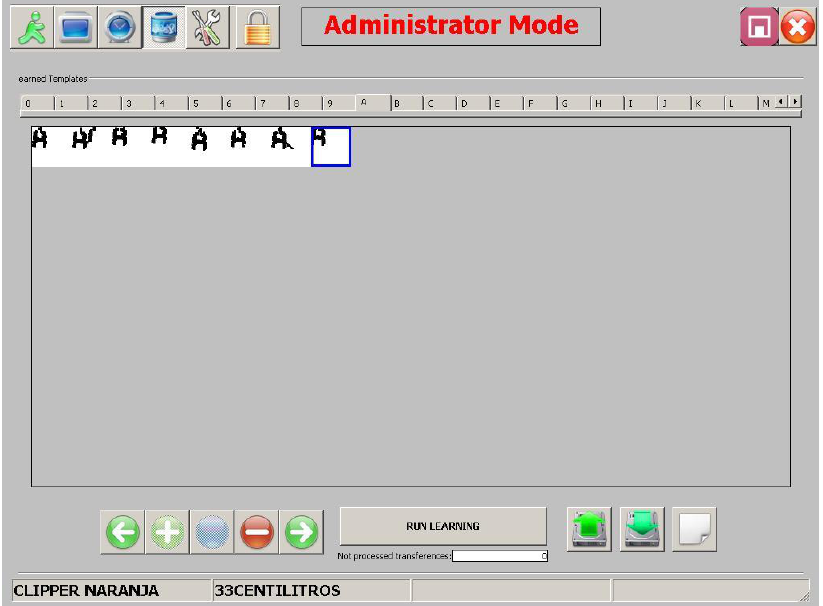
Figure 13. View of the interface of the morphological family database. An operator can select and remove a morphology that is unsuitable or too noisy at the click of a button.